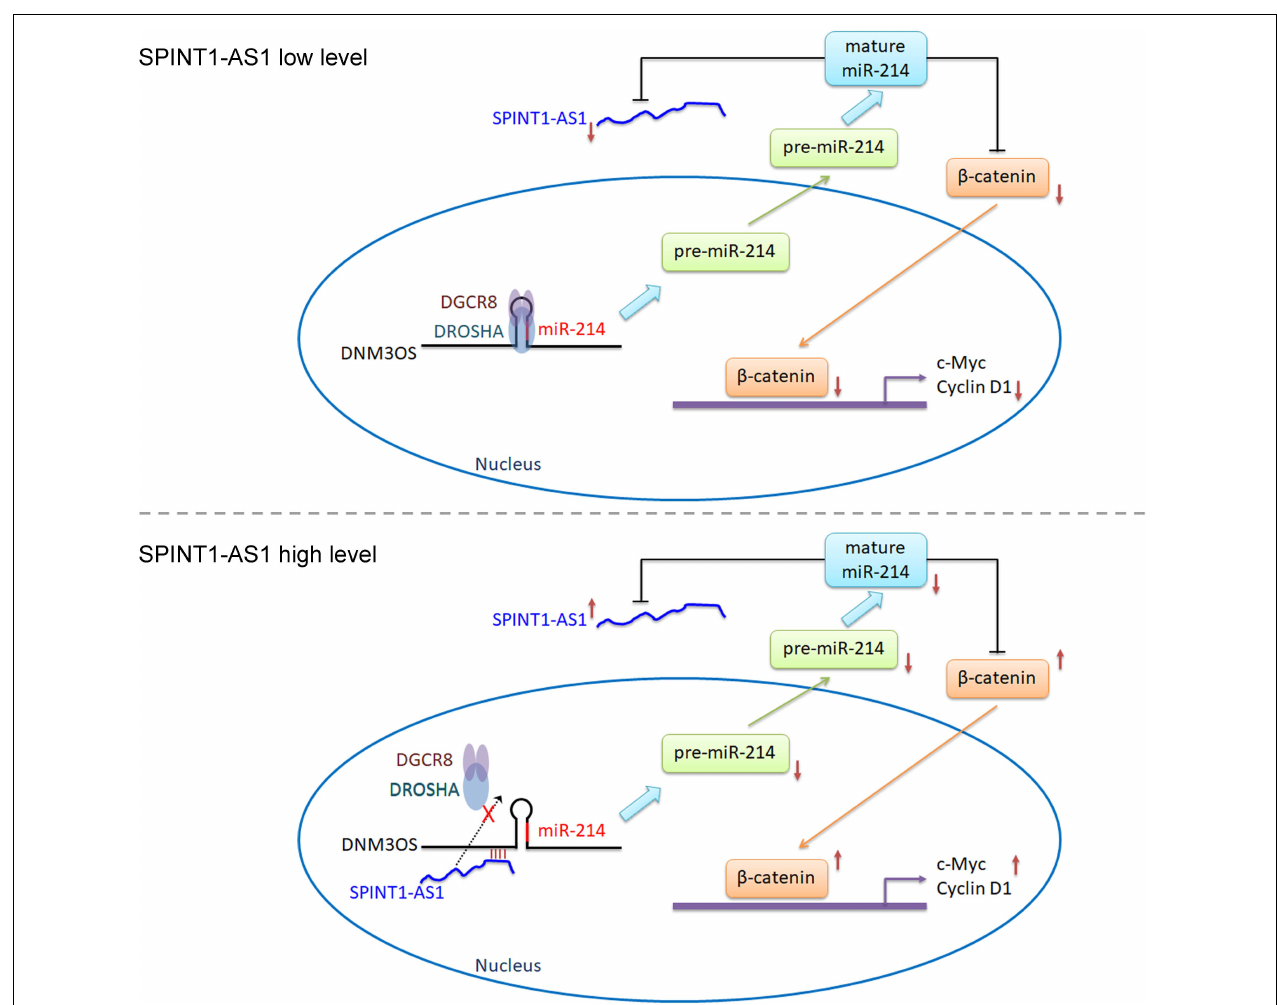
FIGURE 8 | Schematic diagram of the reciprocal repression between SPINT1-AS1 and miR-214.